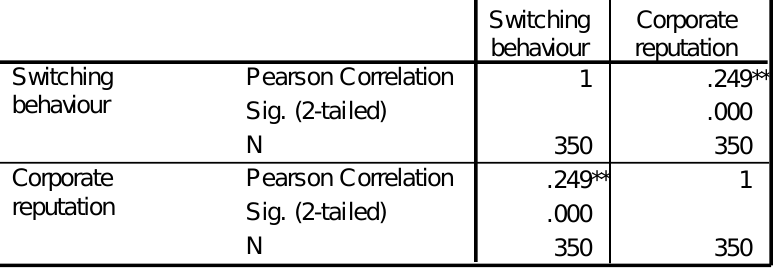
Table 6: Relationship between Corporate reputation and brand switching behavior C o rr e l a t i on